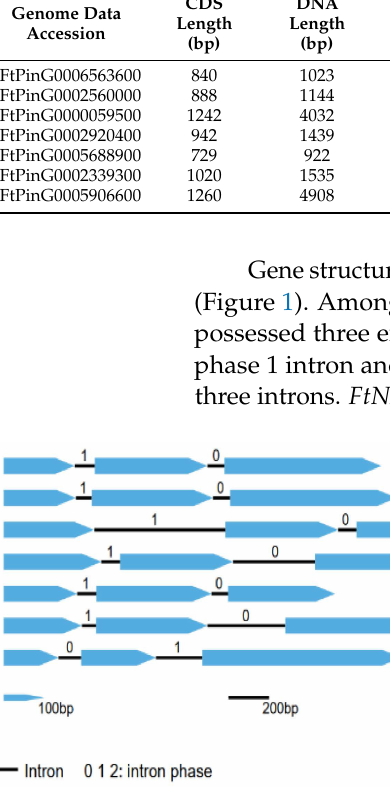
Figure 1. Gene structure of seven